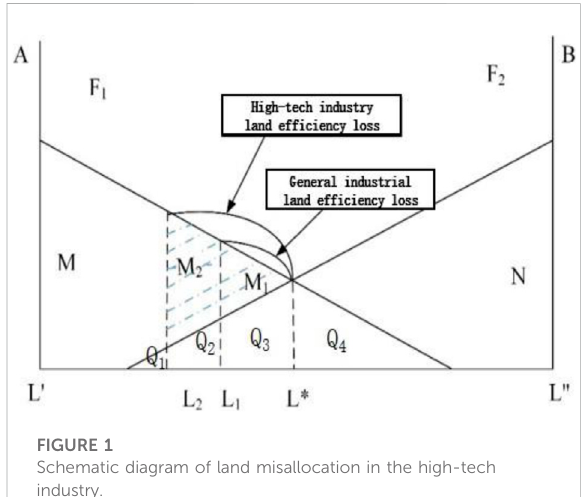
FIGURE 1 Schematic diagram of land misallocation in the high-tech